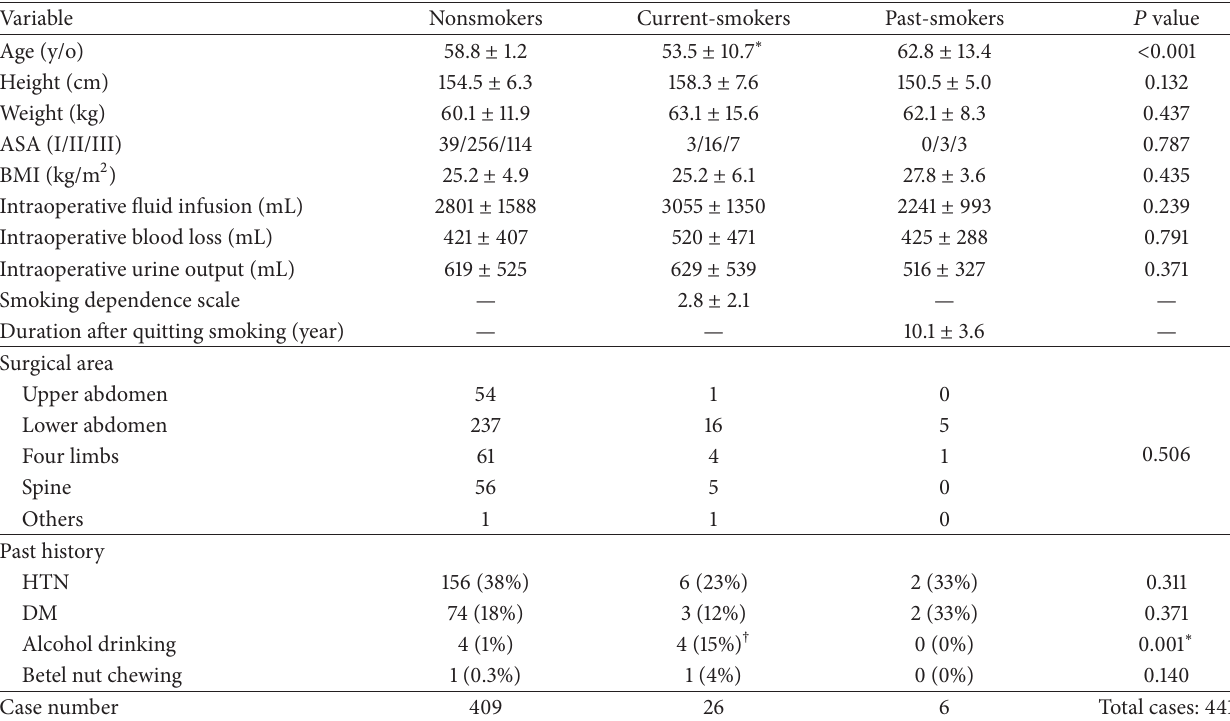
Table 2: Demographic data on female